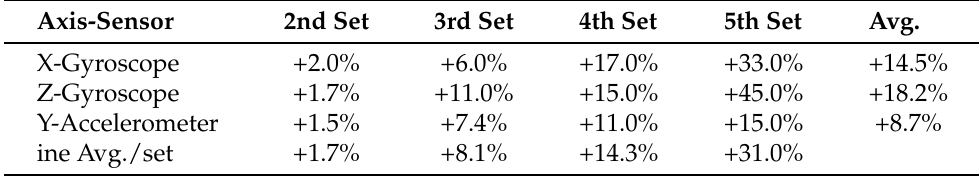
Figure 3. A visualization of the changes that occurred to muscle endurance and angular velocity due to fatigue presence. Table 2. The increase in the percentage of the time to complete a set, compared to the 1st set.